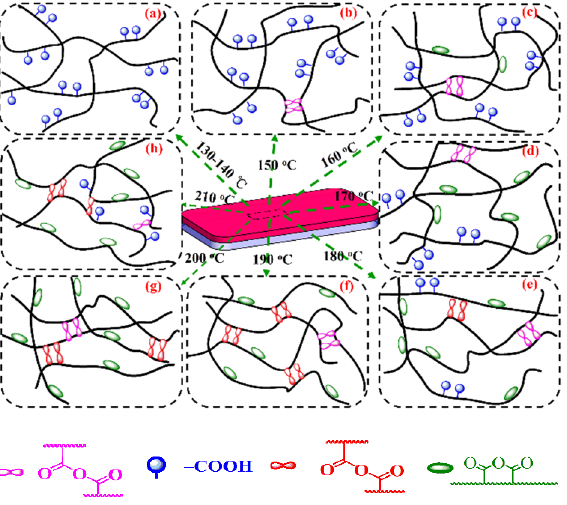
Figure 5. The structure of coating cured at different temperatures: ( a ) coating cured at 130 and 140 °C; ( b ) coating cured at 150 °C; ( c ) coating cured at 160 °C, ( d ) coating cured at 170 °C; ( e ) coating cured at 180 °C; ( f ) coating cured at 190 °C; ( g ) coating cured at 200 °C; ( h ) coating cured at 210 °C.